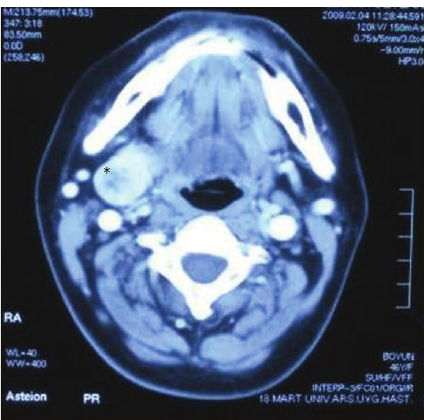
Figure 1: Thyroid mass extension to submandibular area in the first case. “ ∗ ” The thyroid mass.